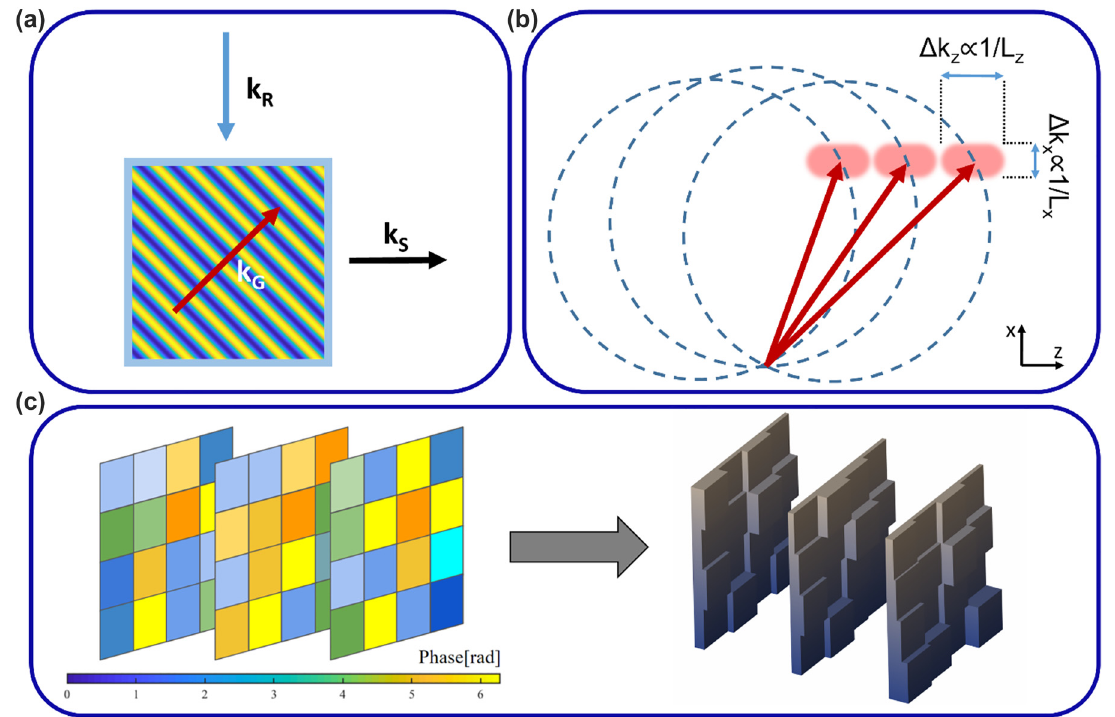
Figure 4: Different holographic strategies. (a) 90 ◦ geometry decoupling the non-diffracted beam and modulated diffracted beam. k to the wave vectors of the reference, signal, and recorded grating, respectively. (b) Bragg-selectivity in k -space separates the different pages of data by mapping them on different Ewald’s spheres due to the different carrier frequencies. The vector clouds are designated by the shaded regions where the size of the cloud inversely depends on the dimensions of the volume hologram, L as well. (c) Schematic for a phase mask stack. The stacked phase masks exhibit volumetric properties when the separation between them is large enough for Fresnel propagation to take place. The varying phase can be encoded as varying thicknesses, which enables the fabrication with a binary-index